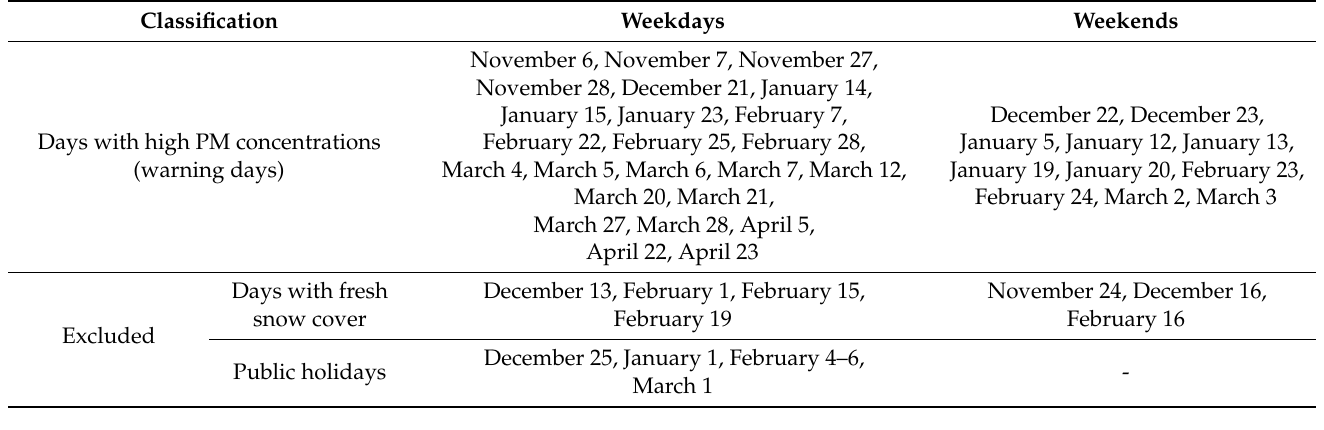
Table 1. Days with high PM concentrations and days excluded due to